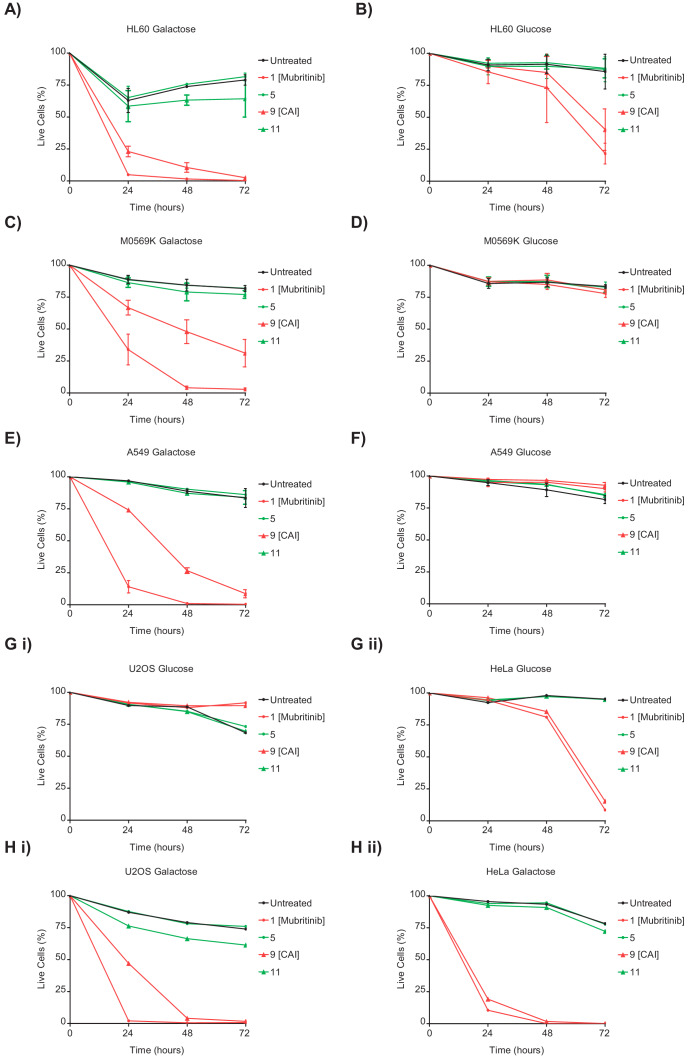
CAI and mubritinib inhibit cell growth and induce apoptosis in glycolytic-deficient tumour cell lines.(A and B) HL60 cells grown in media containing galactose (A) or glucose (B) as an energy source treated with mubritinib (1) (2 μM), CAI (9) (5 μM) or the inactive derivatives 5 (2 μM) or 11 (5 μM). Cells were harvested at the indicated time points and the percentage of live cells assessed by DRAQ7staining and Annexin-V-FITC labelling. Error bars represent standard deviation (n = 3). (C and D) M059K cells grown in media containing galactose (C) or glucose (D) as an energy source treated with mubritinib (1) (2 μM), CAI (9) (5 μM) or the inactive derivatives 5 (2 μM) or 11 (5 μM). Cells were harvested at the time points shown and the percentage of live cells assessed by DRAQ7staining and Annexin-V-FITC labelling. Error bars represent standard deviation (n = 3). (E and F) A549 cells grown in media containing galactose (E) or glucose (F) as an energy source treated with mubritinib (1) (2 μM), CAI (9) (5 μM) or the inactive derivatives 5 (2 μM) or 11 (5 μM). Cells were harvested at the time points shown and the percentage of live cells assessed by DRAQ7staining and Annexin-V-FITC labelling. Error bars represent standard deviation (n = 3). (G) U-20S (i) cells and HeLa (ii) cells were treated with mubritinib (1) (2 μM), CAI (9) (5 μM) or the inactive derivatives compound 5 (2 μM) or compound 11 (5 μM) in media containing glucose as an energy source. Cells were harvested at the time points shown and the percentage of live cells assessed by DRAQ7staining and Annexin-V-FITC labelling. (H) U-20S (i) cells and HeLa (ii) cells were treated with mubritinib (1) (2 μM), CAI (9) (5 μM) or the inactive derivatives compound 5 (2 μM) or compound 11 (5 μM) in media containing galactose as an energy source. Cells were harvested at the time points shown and the percentage of live cells assessed by DRAQ7staining and Annexin-V-FITC labelling.